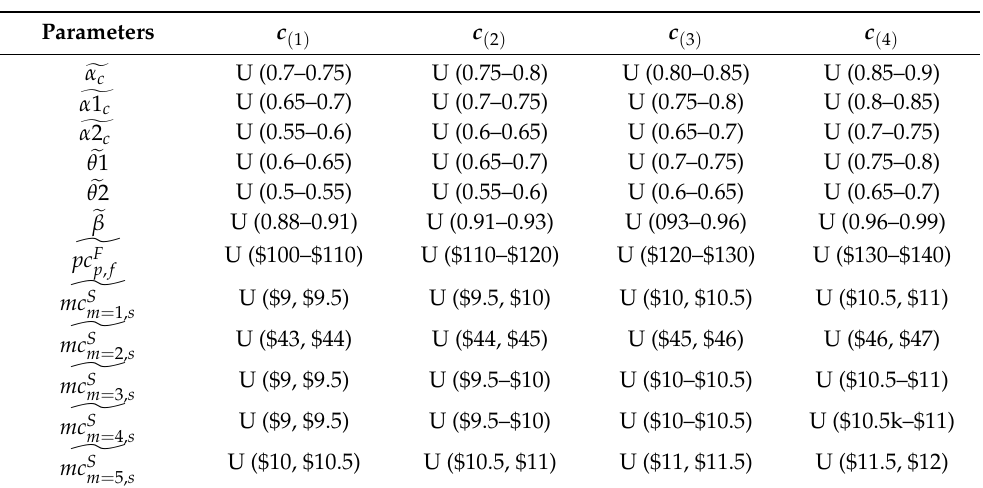
Table 4. Values for fuzzy